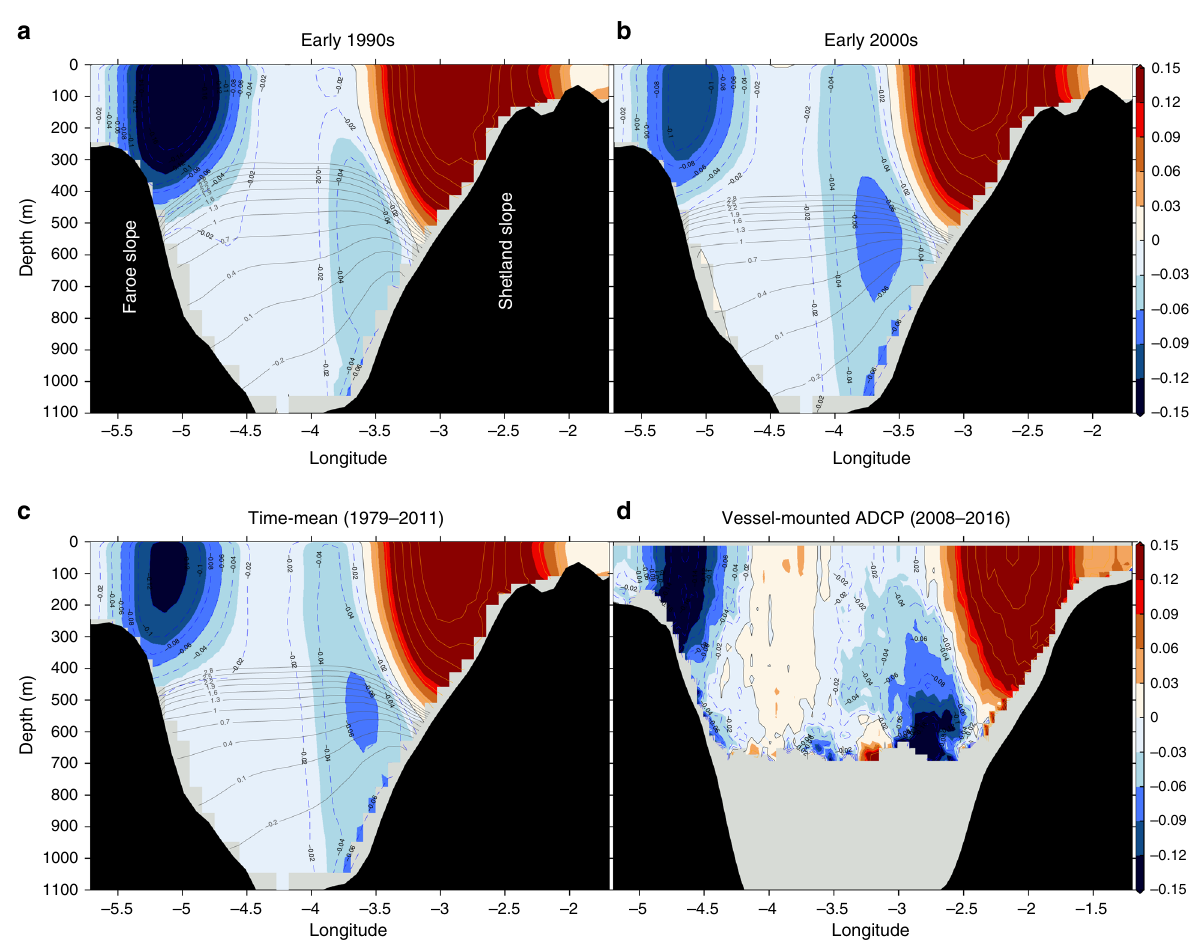
Fig. 5 Capturing the deep eastern jet in the FSC. Modeled velocities (southwards/northwards correspond to red/blue shading) across the Faroe – Shetland Channel (FSC) (Supplementary Fig. 1, inset) averaged for a the early 1990s, b the early 2000s, and c 1979 – 2011 period (model climatology). The gray lines show the corresponding isotherms but only less than 2.8 °C (black shading is bottom topography). d The observed 2008 – 2016 velocities from the vessel- mounted Acoustic Doppler Current Pro fi ler (ADCP, cf. Fig. 1b). Missing data below 600 m is indicated by light gray. The Faroe – Shetland Channel jet (FSCJ) is banked against the eastern slope as indicated by the sloping isotherms (thin gray lines). It is also strongly bottom-intensi fi ed and has another a core at intermediate depths. The overall structure of the FSCJ is similar between the modeled mean velocity and that based on the 9-year long ADCP data (2008 – 2016) from Norröna (see Methods